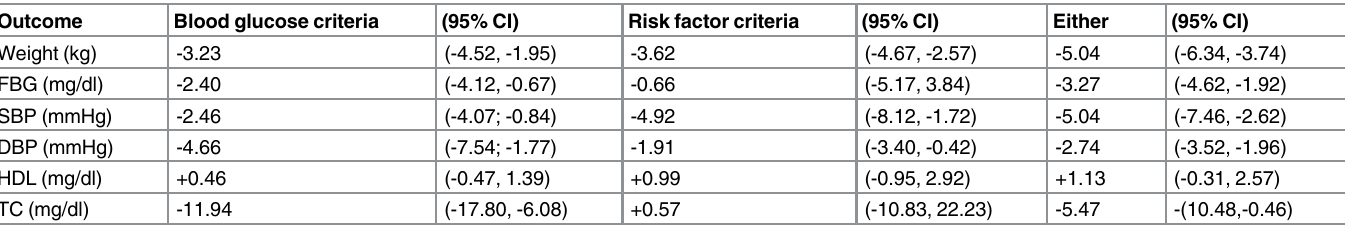
Table 5. Outcomes stratified by method used to determine “ high risk ” status. (Supporting forest plots in S7 Fig.) Outcome Blood glucose